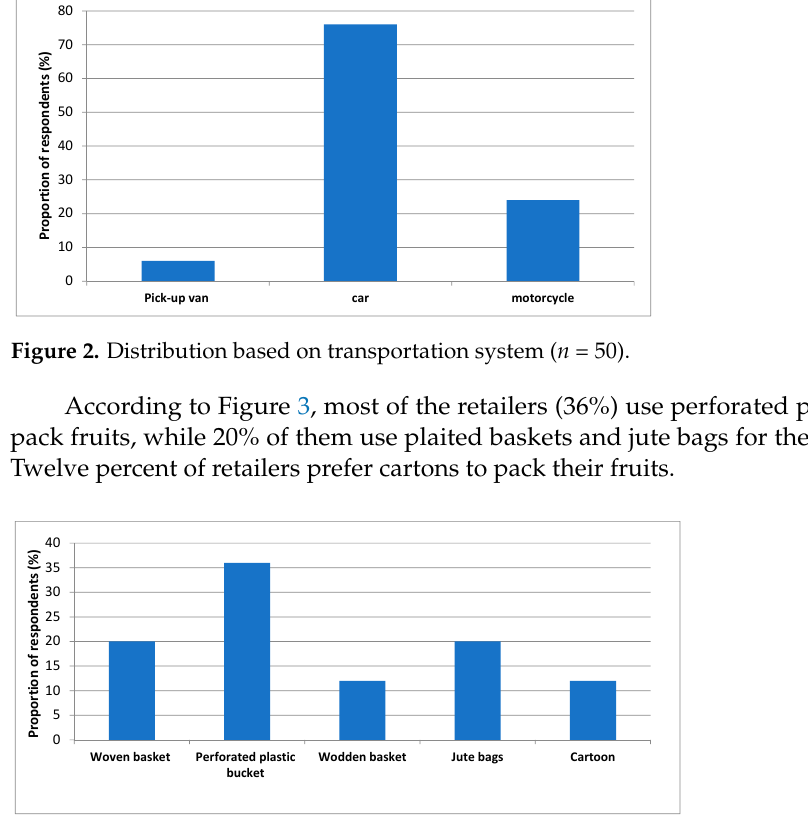
Figure 3. Distribution of respondents according to the types of packaging materials ( n = 50).